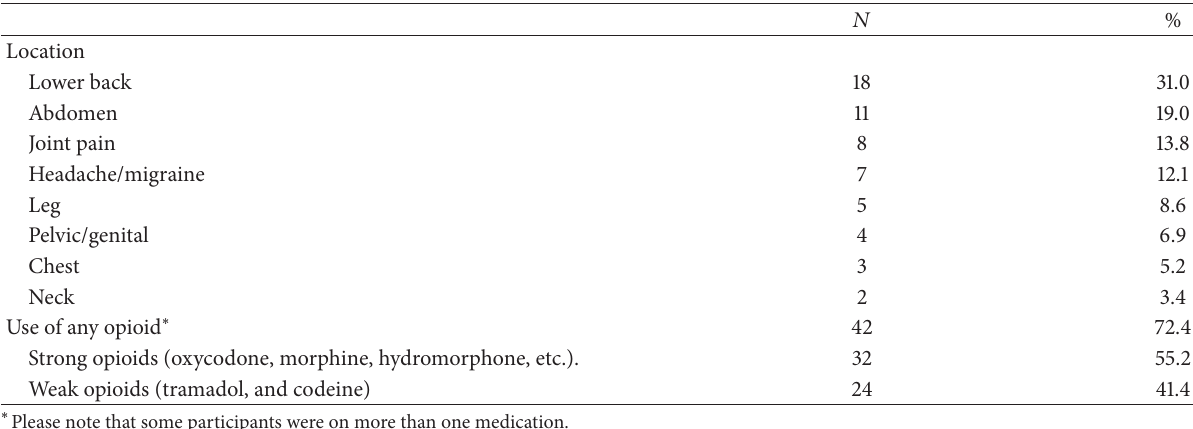
Table 2: (a) Primary pain problem. (b) Healthcare usage